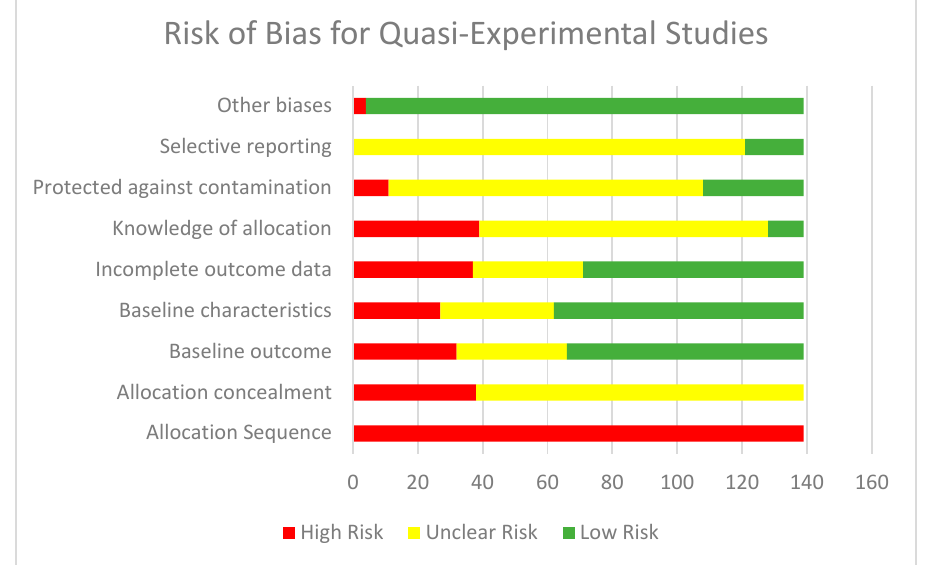
Figure 3. Summary risk of bias for included quasi-experimental studies.